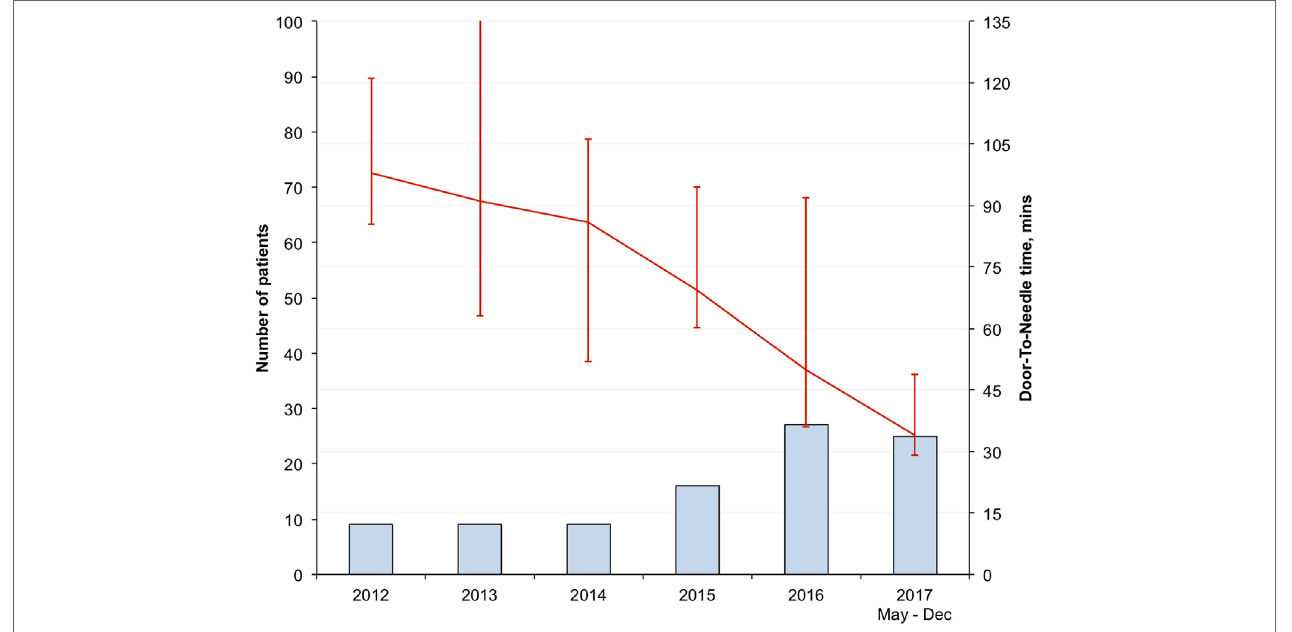
FigUre 1 | In-hours median door-to-needle time in